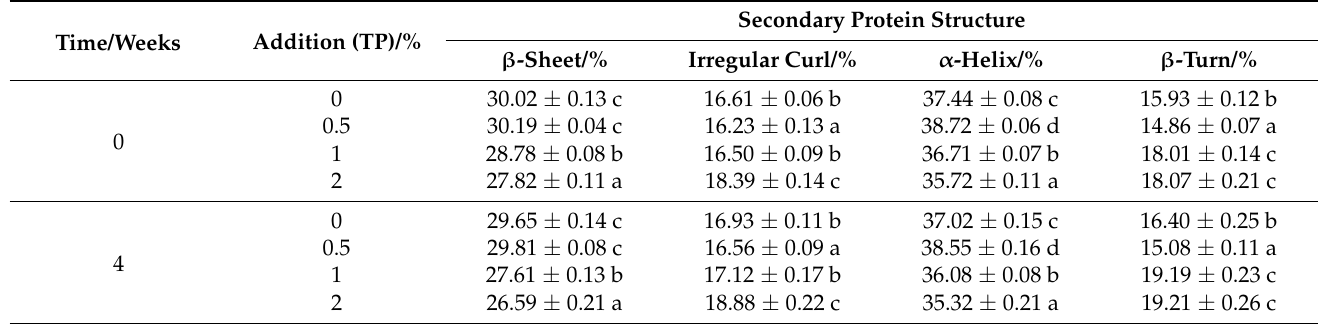
Values with different letters indicate significant difference among samples at the same frozen storage time ( p <